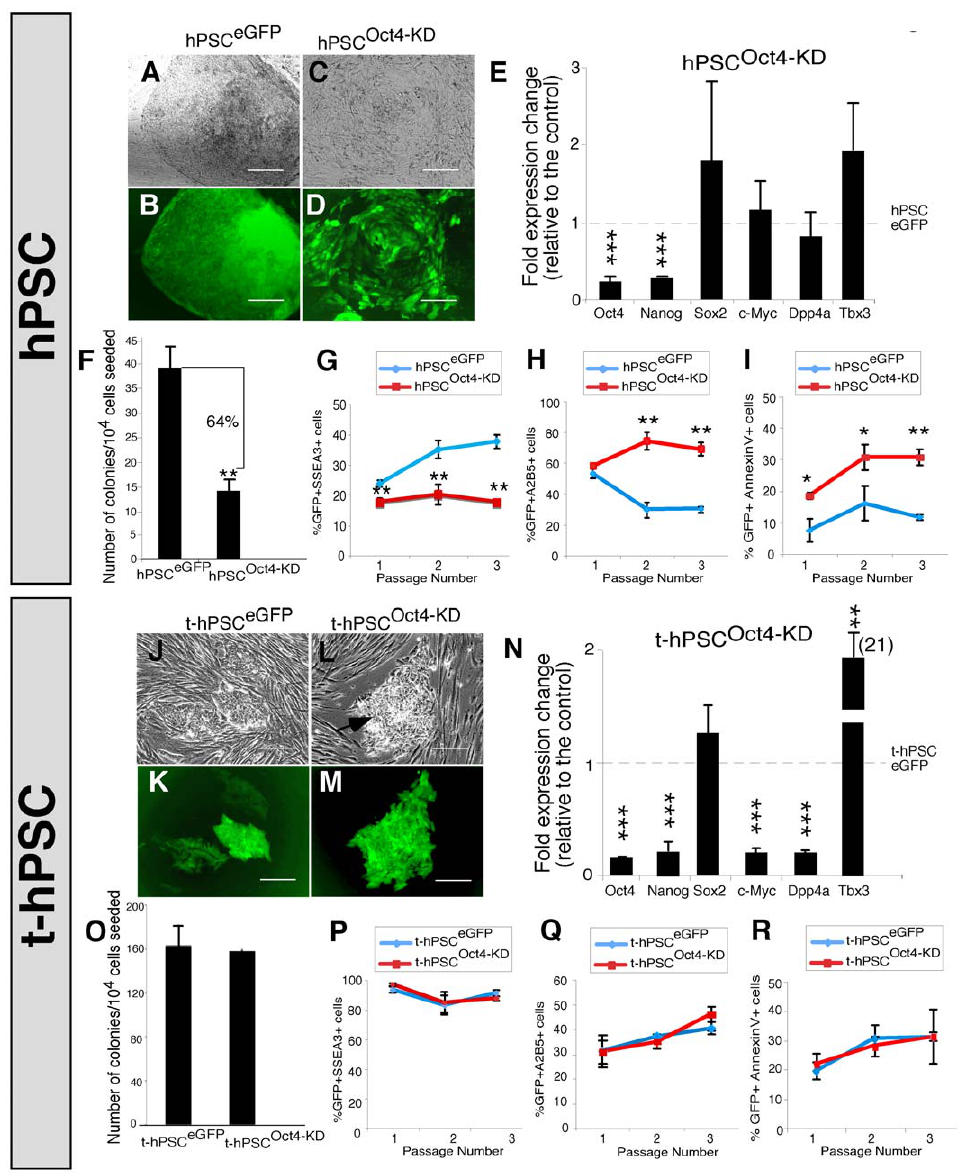
Figure 1. Oct4 knockdown does not affect self-renewal, differentiation and survival of t-hPSCs. (A–D) Representative images of colonies generated from GFP + SSEA3 + cells 11 days post-sort from control (A and B) and Oct4 knockdown (C and D) normal hPSCs. Scale bar=100 m m, n=3. Note the compact appearance and well-defined border of the typical hPSC colony in A and B. In contrast, the cells within the more differentiated colony in C and D exhibit a higher cytoplasm to nuclear ratio, are less compact, and do not form a well-defined colony border. (E) qPCR of fold changes in Oct4, Nanog, Sox2, c-Myc, Dpp4a, and Tbx3 transcripts in Oct4 knockdown hPSCs relative to hPSC eGFP controls. Bar graphs represent mean values 6 SEM, n=3, ***, p , 0.001. (F) Clonogenic self-renewal of SSEA3 + cells isolated from control (39.3 6 4.3 6 10 4 ) and Oct4 knockdown (14 6 2.3 6 10 4 ) hPSCs. 1 6 10 4 GFP + SSEA3 + cells were isolated from hPSCs 2 days after transduction with eGFP control and Oct4 knockdown lentiviral vectors and seeded on ihdFs. GFP + colonies were scored 9 days after seeding. Bar graphs represent mean values 6 SEM, n=3. **, p , 0.01. (G–I) Frequency of GFP + SSEA3 + (G) GFP + A2B5 + (H) and GFP + AnnexinV + (I) cells for three passages of culture derived from sorted GFP + SSEA3 + fractions of control and Oct4 knockdown hPSCs. N=3 for each. Line graphs represent mean values 6 SEM. * p , 0.05, ** p , 0.01. (J–M) Representative images of colonies generated from sorted GFP + cells 6 days post-sort from control (J–K) and Oct4 knockdown (L–M) t-hPSCs. Scale bar=100 m m, n=5. Arrow denotes the typical appearance of tightly packed undifferentiated colonies. (N) qPCR of fold changes in Oct4, Nanog, Sox2, c-Myc, Dpp4a, and Tbx3 transcripts in Oct4 knockdown t-hPSCs relative to t-hPSC eGFP control cells. Bar graphs represent mean values 6 SEM, n=3, **, p , 0.01, ***, p , 0.001. (O) Clonogencity of GFP + cells isolated from control and Oct4 knockdown t-hPSCs. 1 6 10 4 GFP + cells were sorted from t-hPSCs 4 days after transduction with eGFP control and Oct4 knockdown lentiviral vectors and seeded on ihdFs. GFP + Colonies were scored 6 days after. Bar graphs represent mean values 6 SEM, n=3. (P–R) Frequency of GFP + SSEA3 + (P) GFP + A2B5 + (Q) and GFP + AnnexinV + (R) cells for three passages of culture derived from sorted GFP + fractions of control and Oct4 knockdown t-hPSCs. P, n=9. Q, n=5, R, n=3. Line graphs represent mean values 6 SEM.